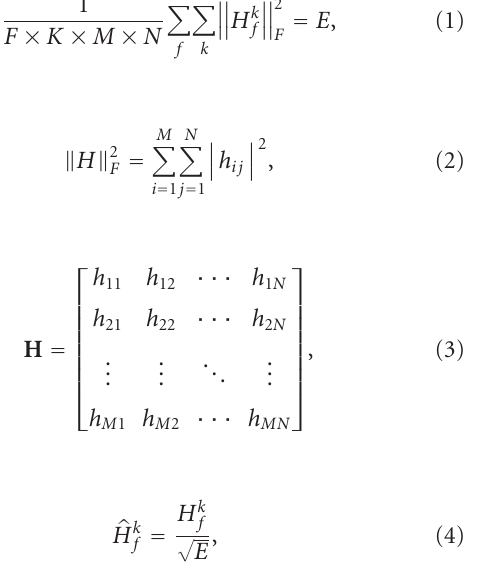
Figure 2: The experimental layout for indoor LOS environment.